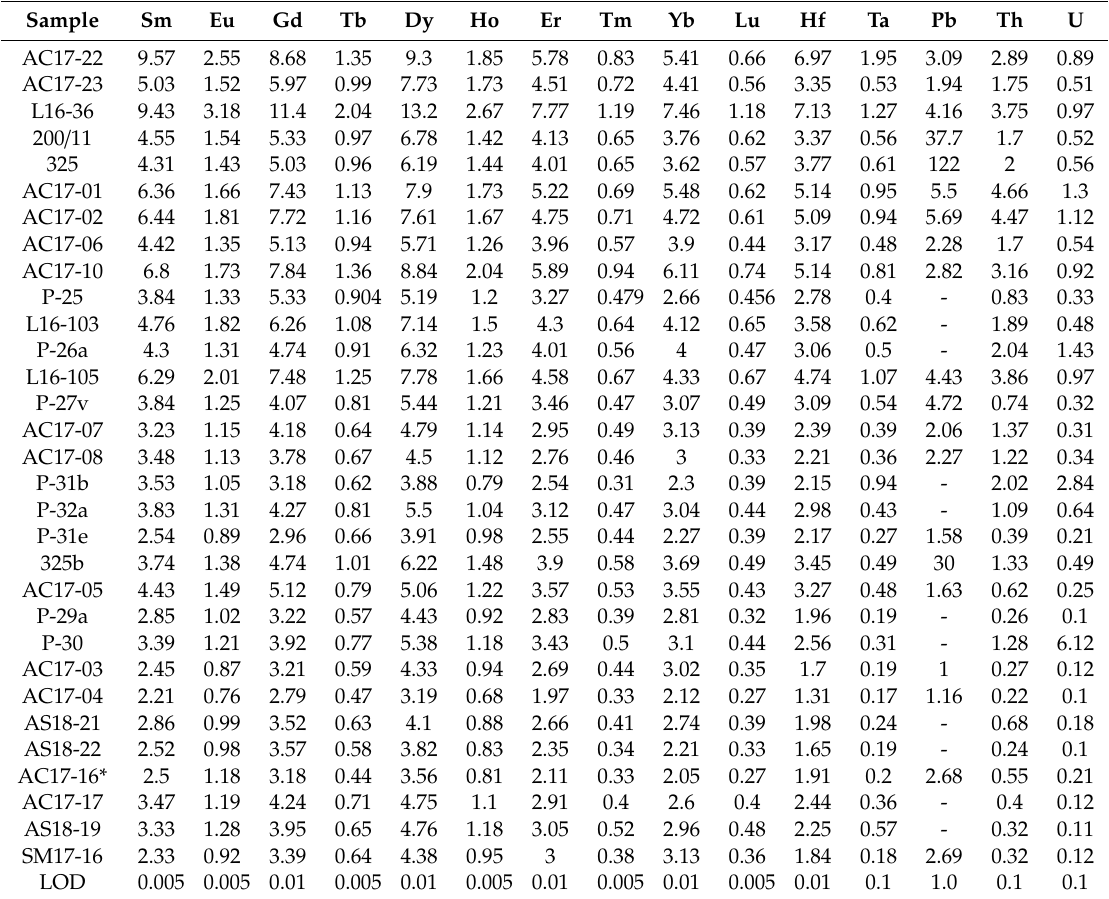
Table A4. The results of whole-Rock Major and Trace Element Measurements (continuation).